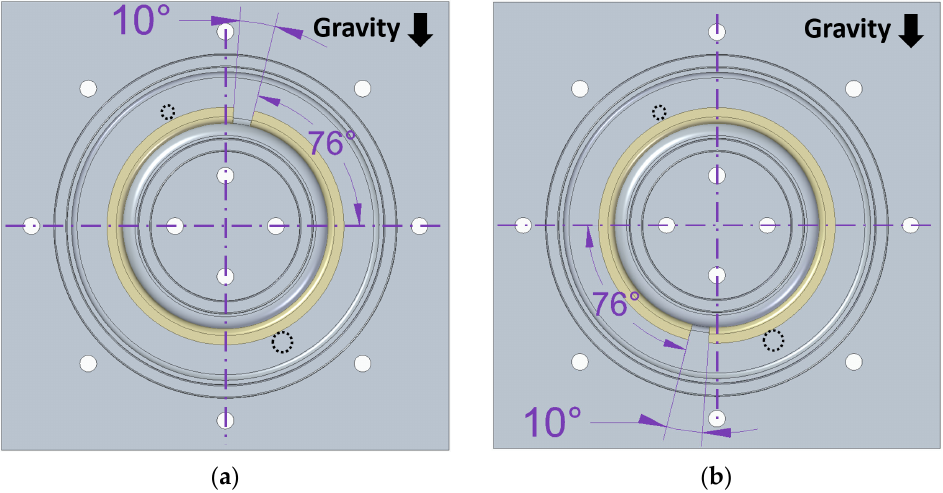
Figure 8. De fi nition of the investigated assembly cases. ( a ) Bearing cut-o ff in the top position; ( b ) Bearing cut-o ff in the bo tt om position. ( b ) Bearing cut-off in the bottom position. Table 2. Material properties of AK 1,000,000 STAB silicone oil used for measurements. Table 2. Material properties of AK 1,000,000 STAB silicone oil used for